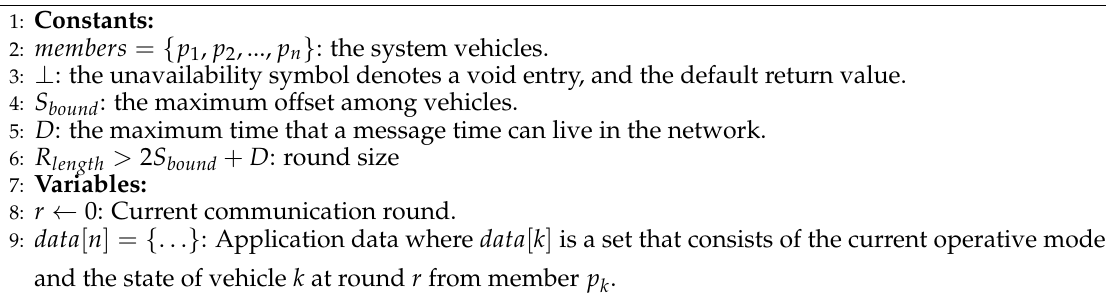
Algorithm 1 Timed Protocol for Cooperation with Disagreement Correction (code for p i